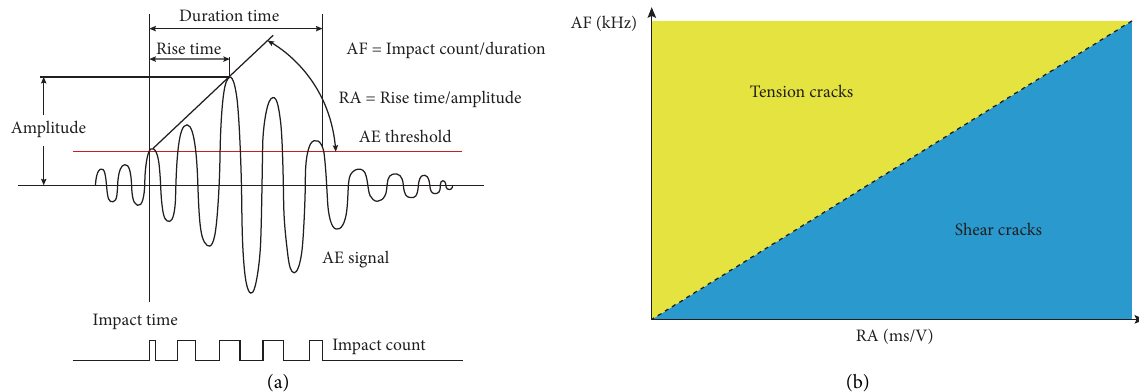
Figure 6: AE signal timing parameters and crack types. (a) AE signal timing parameters. (b) Crack classification.